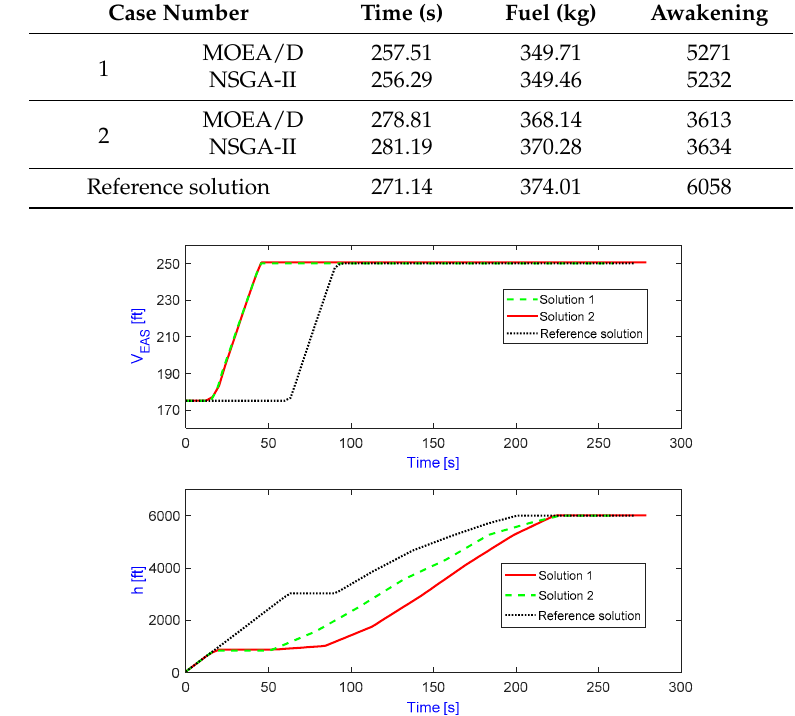
Figure 9. Vertical profiles of cases 1–2, and the reference solution.